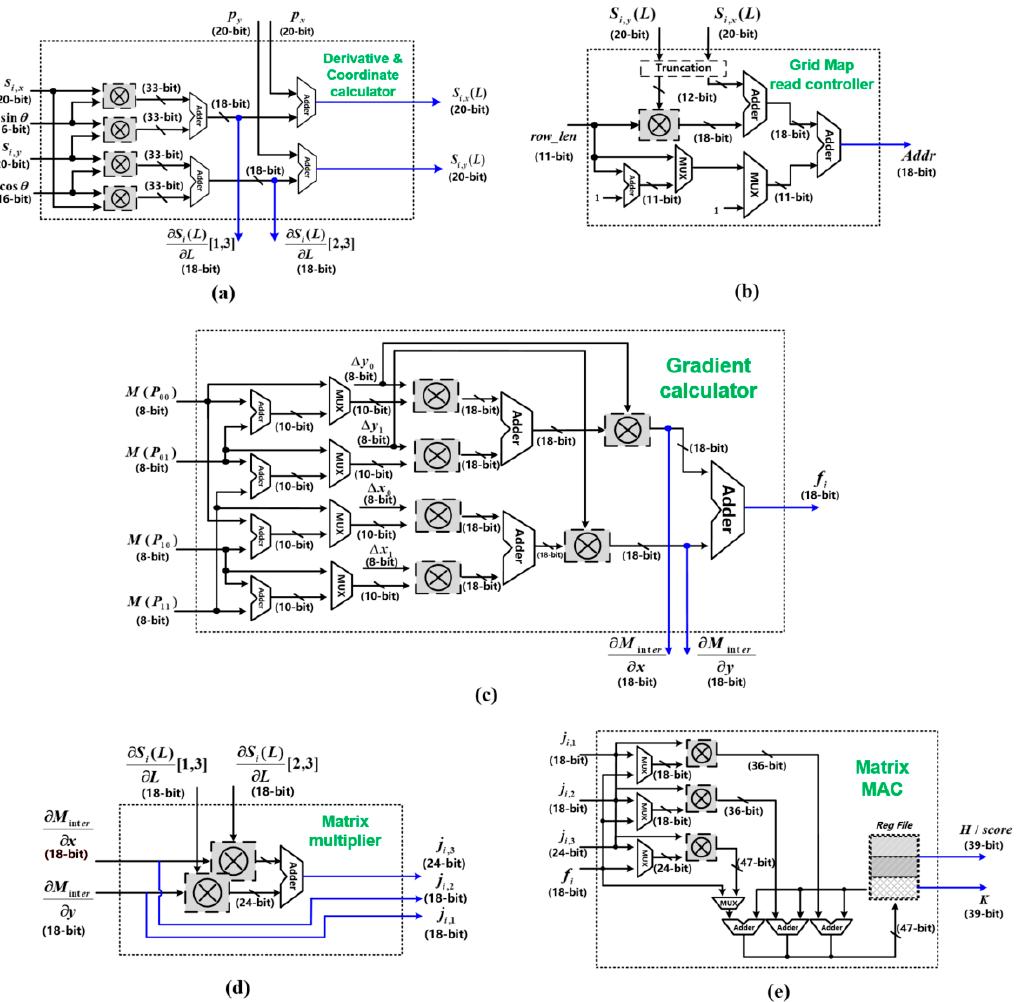
Figure 12. Hardware architectures of ( a ) Derivative and Coordinate calculator; ( b ) grid map read controller; ( c ) gradient calculator; ( d ) matrix multiplier; ( e ) matrix MAC unit in the proposed NLO- CSM hardware accelerator design.